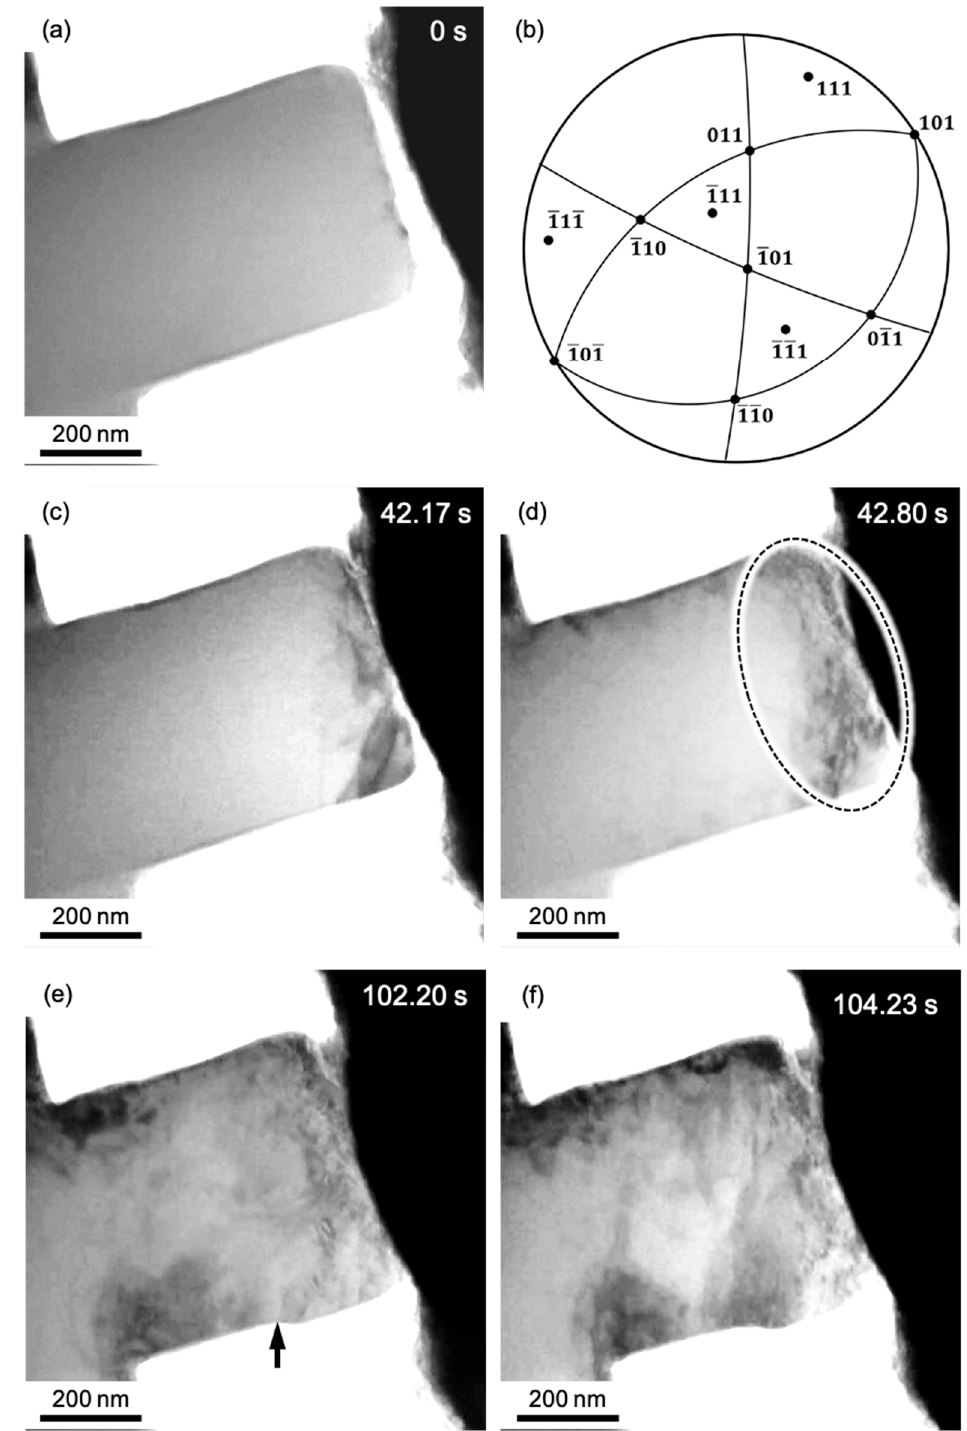
Figure 6. ( a ) Bright-field image of the post-annealed Al pillar before compression. ( b ) Stereographic projection showing the geometry of the Al pillar in ( a ). ( c – f ) Series of snapshots during the TEM in situ compression corresponding to points C-F on the S–S curve in Figure 5,